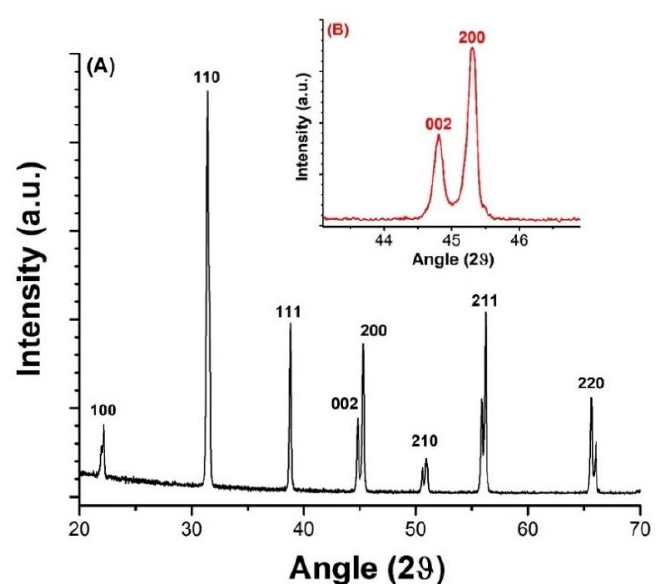
Figure 6. XRD pattern of BaTiO 3 nanoparticles: ( A ) in the whole range of 20° – 70°, ( B ) zoom-in on the 2𝜃 region of 44° and 46°.